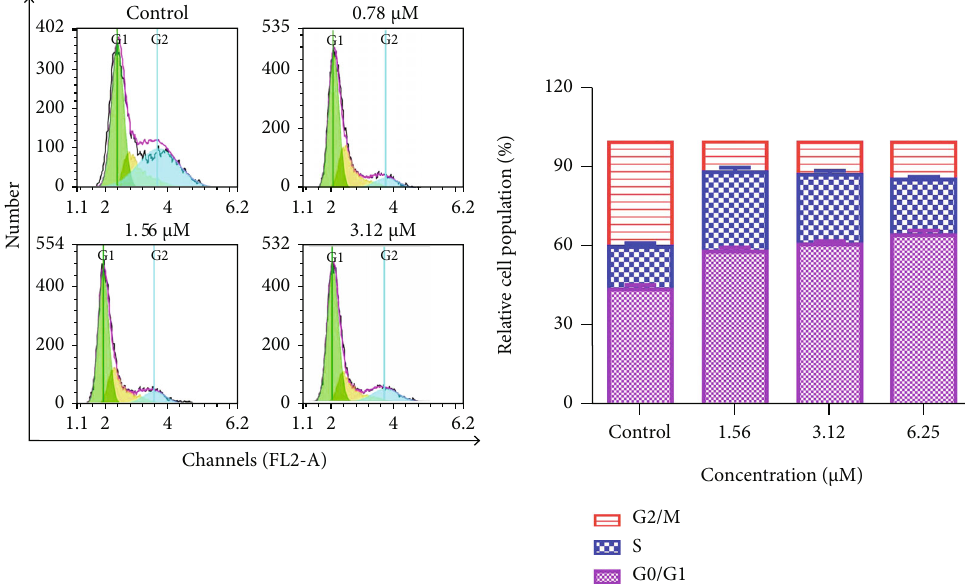
Figure 2: E ff ect of shikonin on cell cycle distribution. H1299 cells were treated with shikonin (0, 0.78, 1.56, and 3.12 μ M) for 48h followed by staining with propidium iodide for fl ow cytometric analysis. Data are presented as the mean ± standard errorof the mean ( n = 3